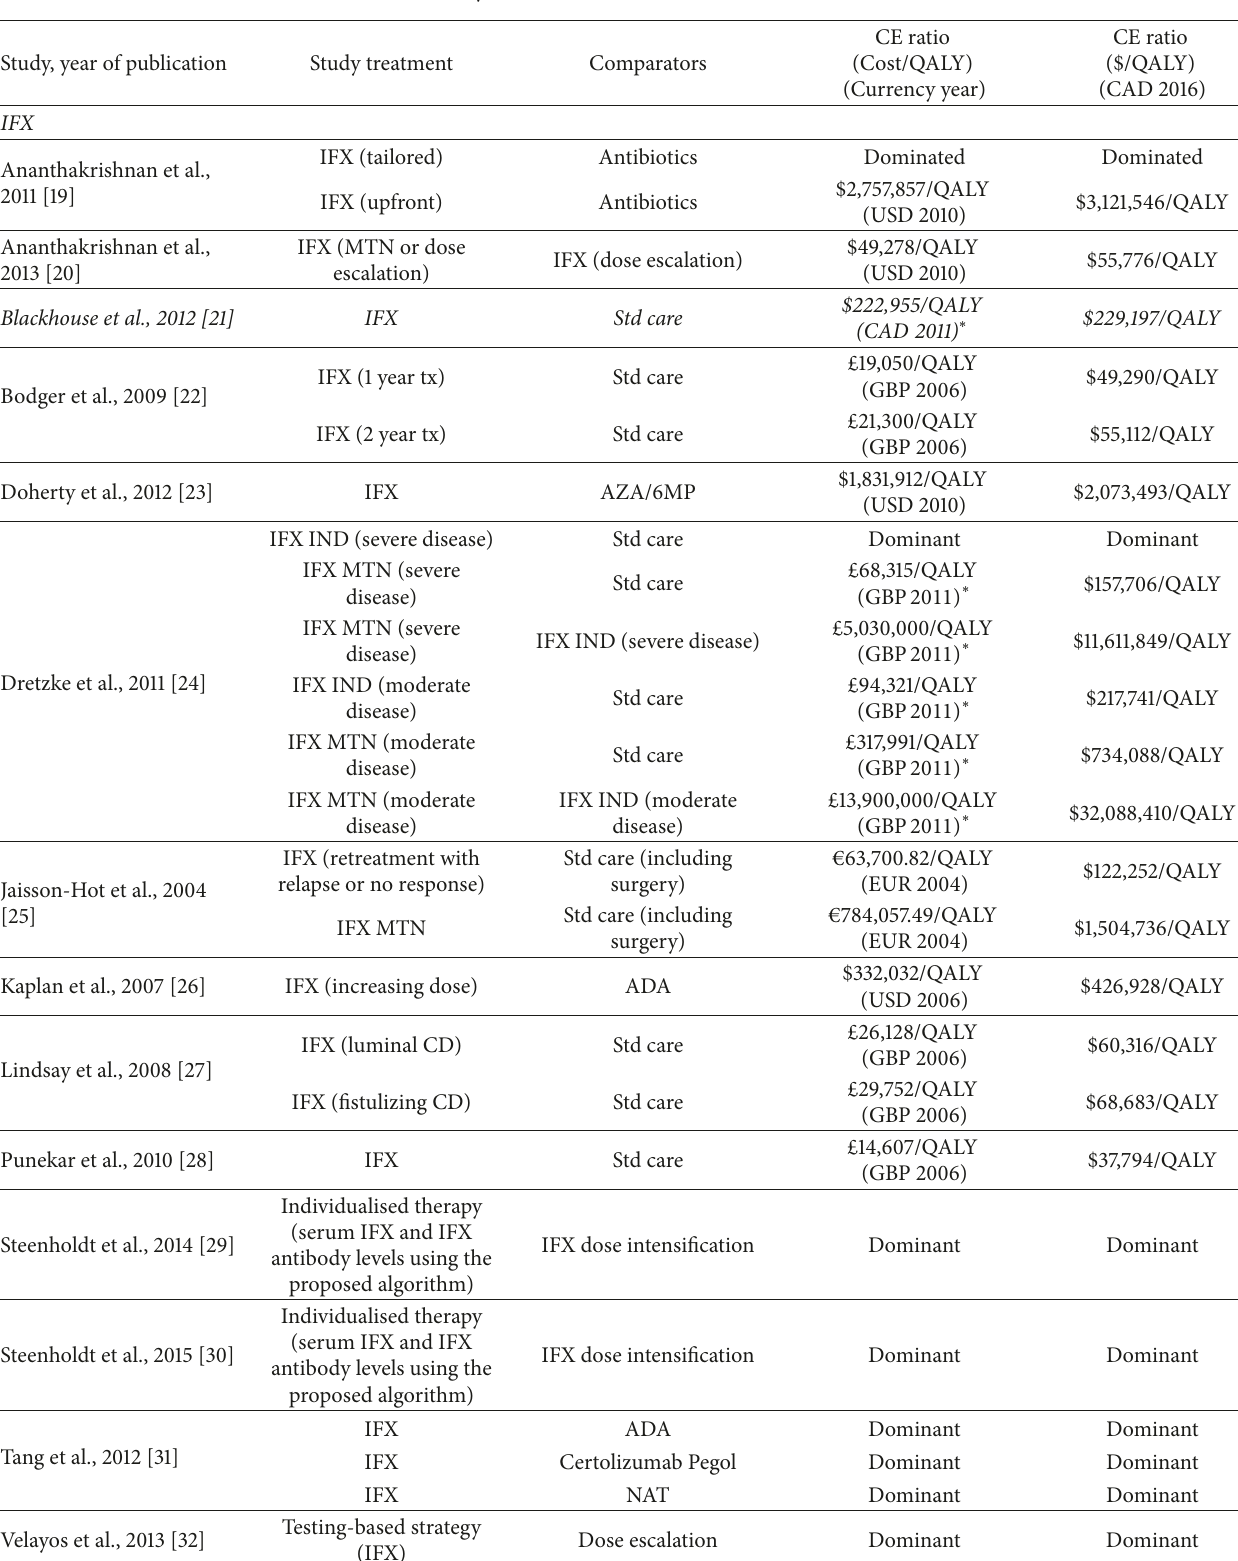
Table 2: Summary of economic evaluations in the treatment of